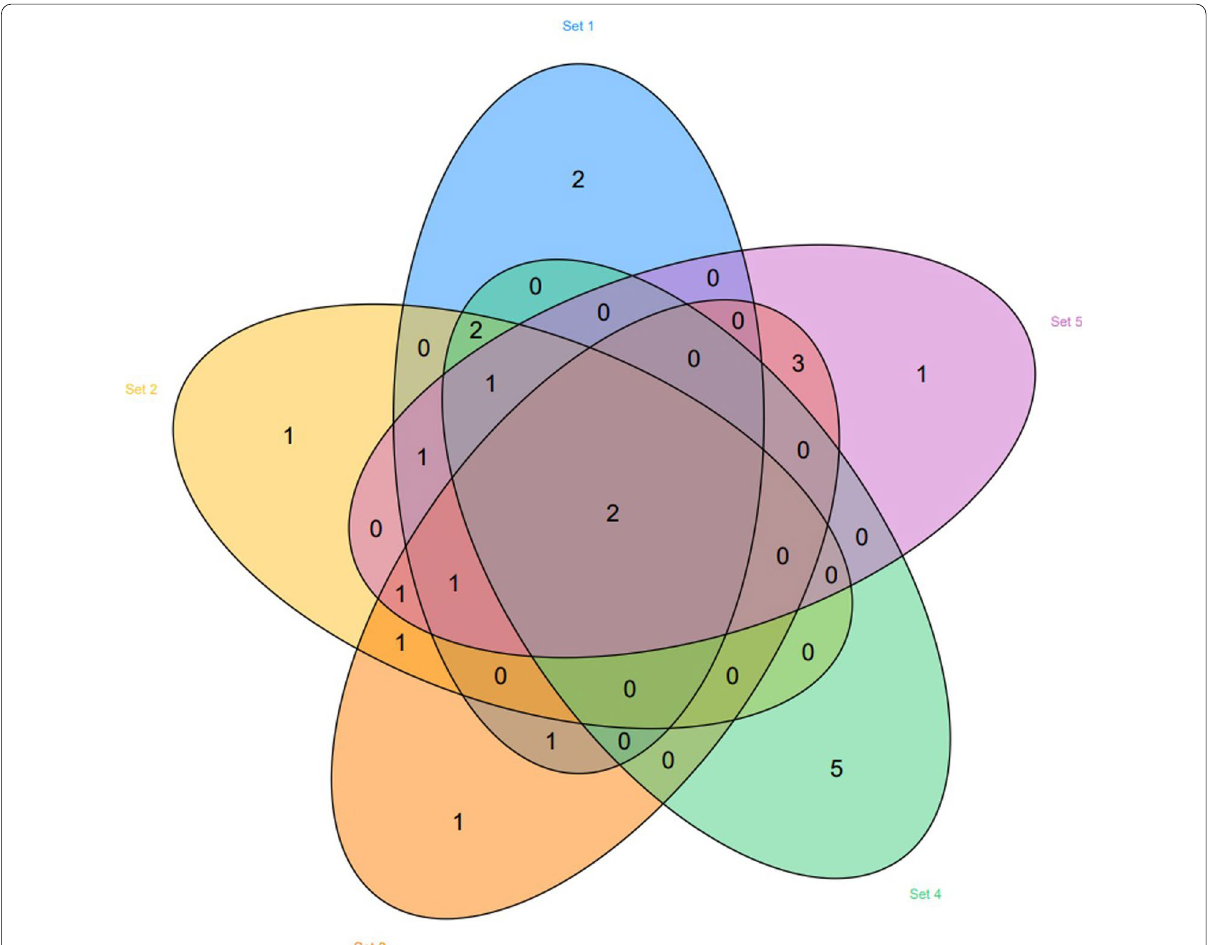
Fig. 5 Overlapping of top ten genes using betweenness, degree, closeness, bottleneck and radiality of cytoHubba resulted to identify two hub